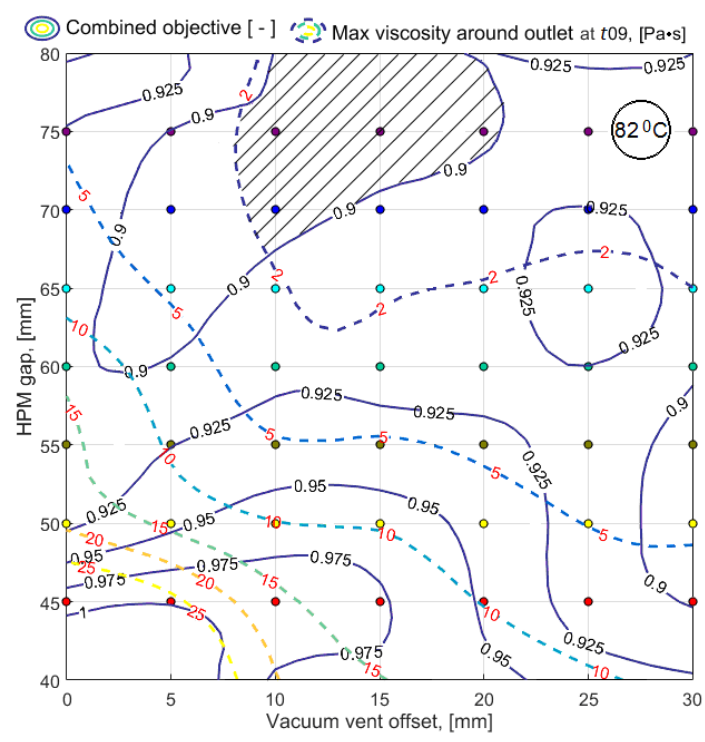
  09 tCObj (solid   09max t out  (dashed lines). The